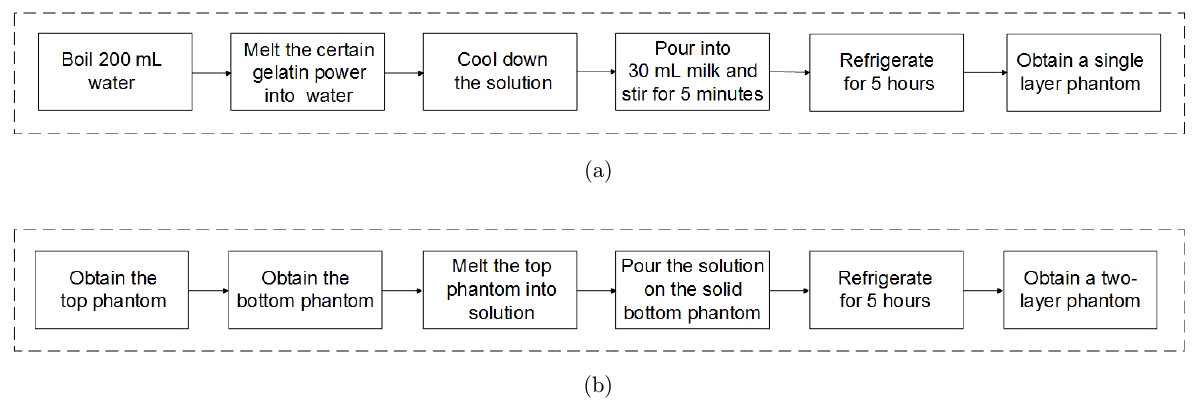
Fig. 4. The °ow chart of constructing the two-layer